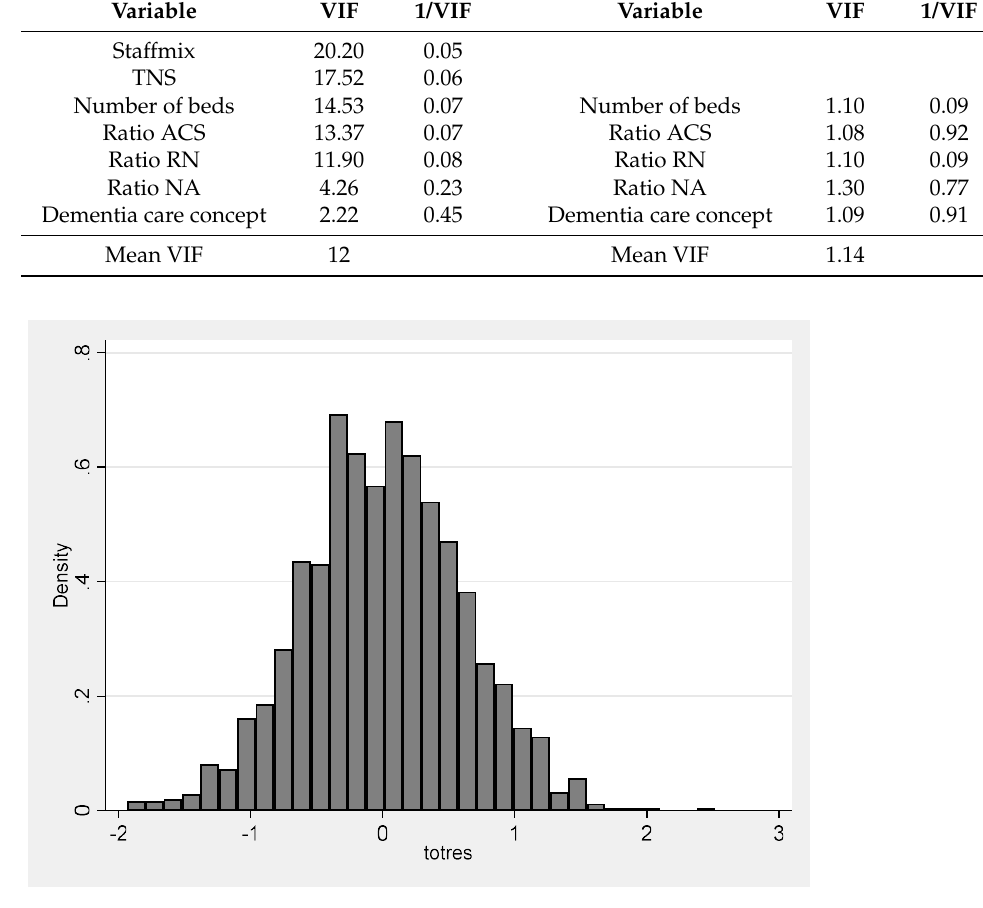
Figure A1. Distribution of total residuals.